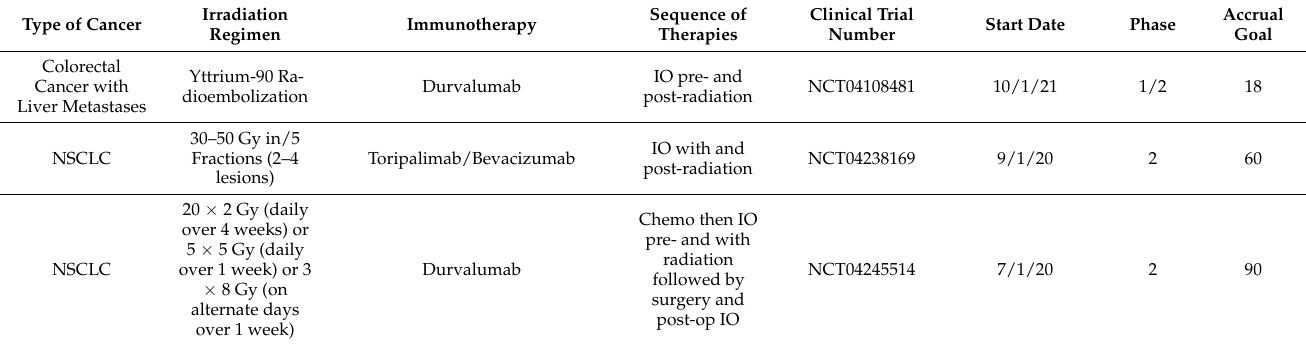
Table 1. A selection of ongoing clinical trials evaluating abscopal responses and/or combination radiation and immunotherapy. NSCLC = non- small-cell lung cancer, RCC = renal cell carcinoma, and H&N SCC = head and neck squamous cell carcinoma. Type of